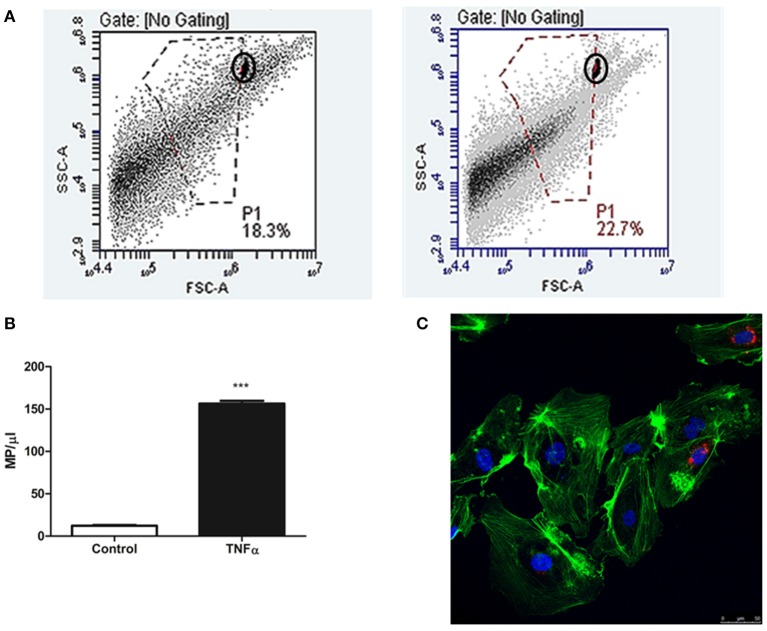
(A) Diagram of flow cytometry events that indicates the events corresponding to EMPs isolated from supernatants of HUVEC cultures treated with TNFalpha at 24 h (right) and control HUVECs (left). The MP population separated from background noise by manual gating, using 1-μm diameter fluorescent microspheres as a reference (circled). The X axis represents size (FSC-A), whereas the Y axis represents complexity (SSC-A), both in Log units. (B) Representative histogram of the quantity of isolated MPs secreted under these two conditions (control vs. TNFalpha 24 h). ***p < 0.001 vs. Control. (C) Confocal microscopy image at 24 h of HUVEC culture with 105 MPs/ml. The MPs can be observed (marked in red with CellTracker™ CM-DiI) as accepted by the recipient cell, preferentially distributed within a perinuclear position.